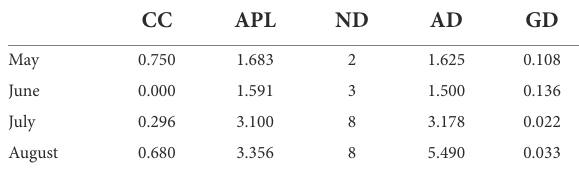
TABLE 1 Topological properties of the co-occurrence network of pathogenic bacterial communities.